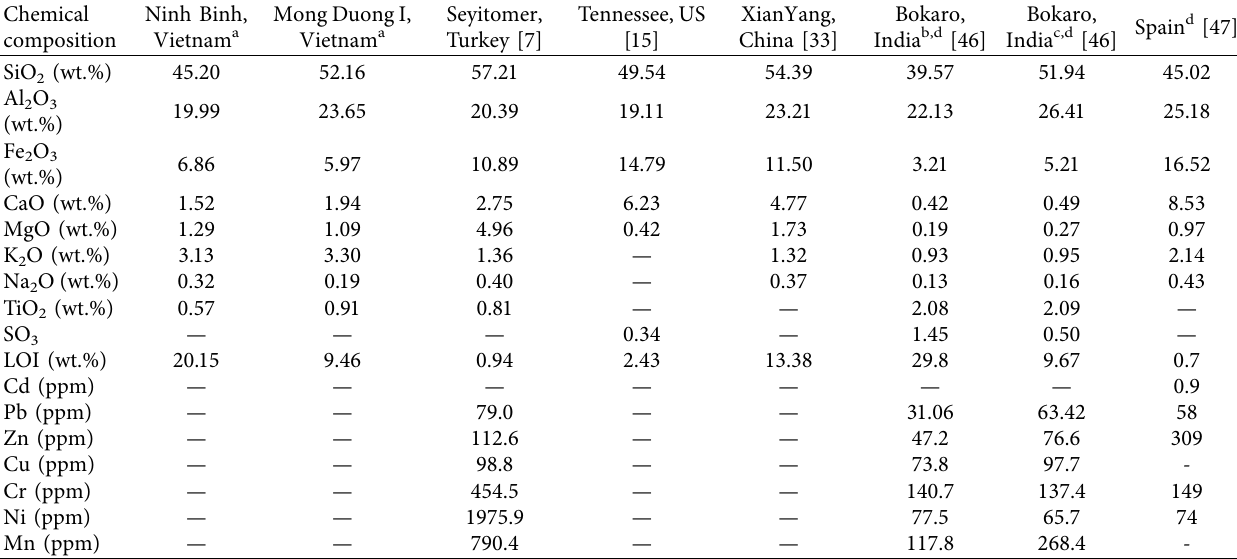
Figure 2: Fly ash particle size distribution. Table 1: Chemical composition of fy